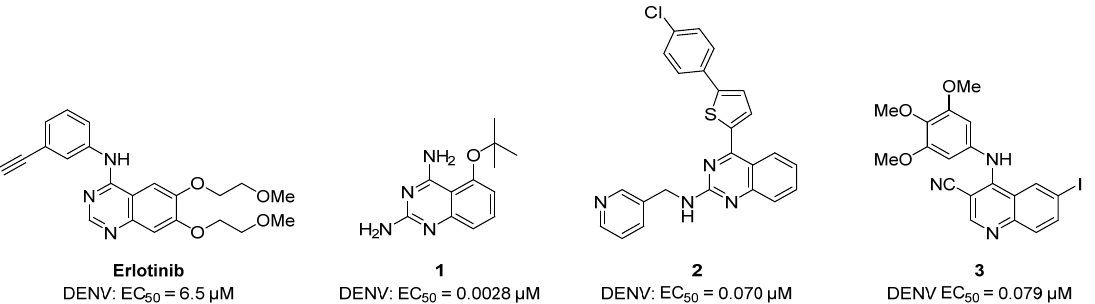
Figure 1. A selection of previously reported quinazolines and quinolines with anti-DENV activity (the data is all for serotype 2 for consistency).